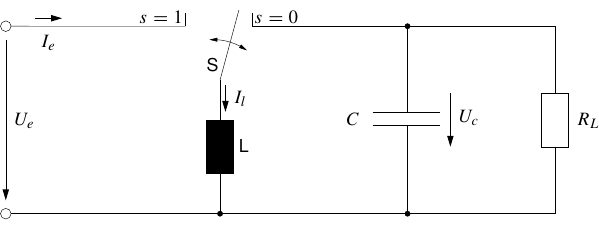
Figure 5. Lossless buck-boost converter with resistive